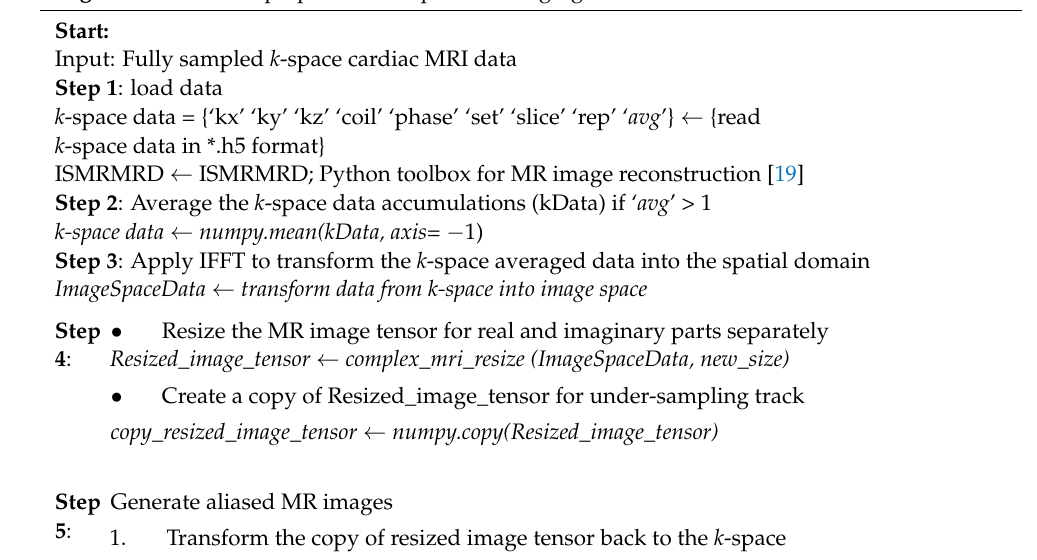
Algorithm 1 Dataset preparation for parallel imaging